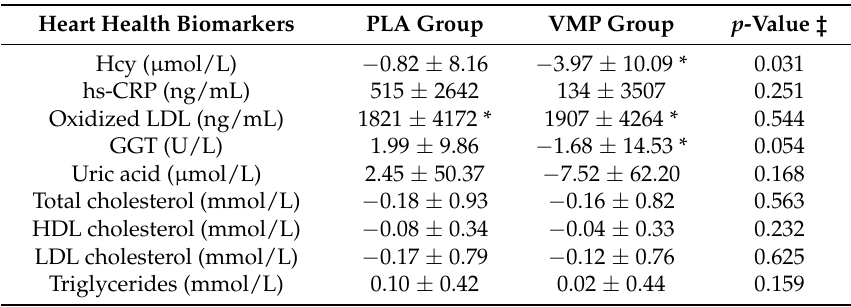
Table 6. Change in CVD biomarkers after 56 days of dietary supplementation. Heart Health Biomarkers PLA